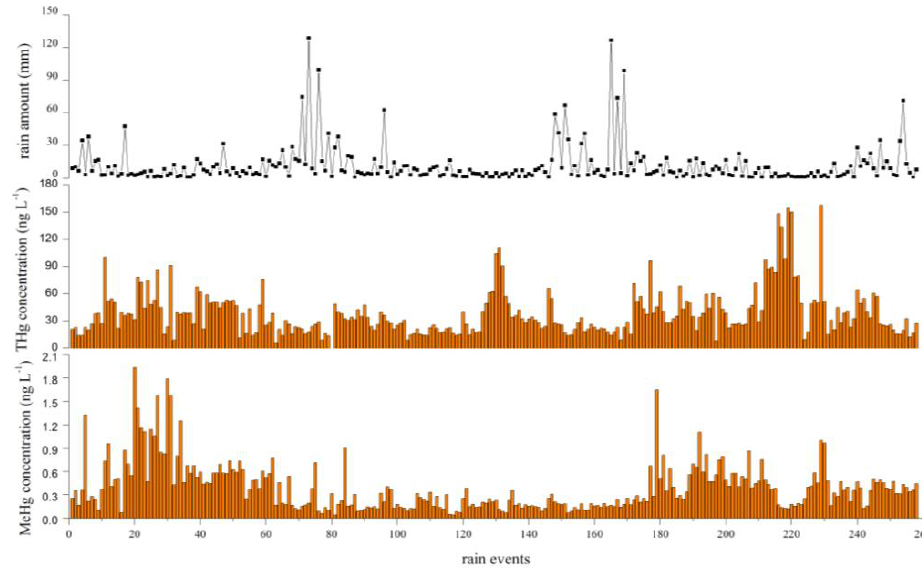
Fig. 6. The relationship between THg and MeHg concentrations with rain amount.